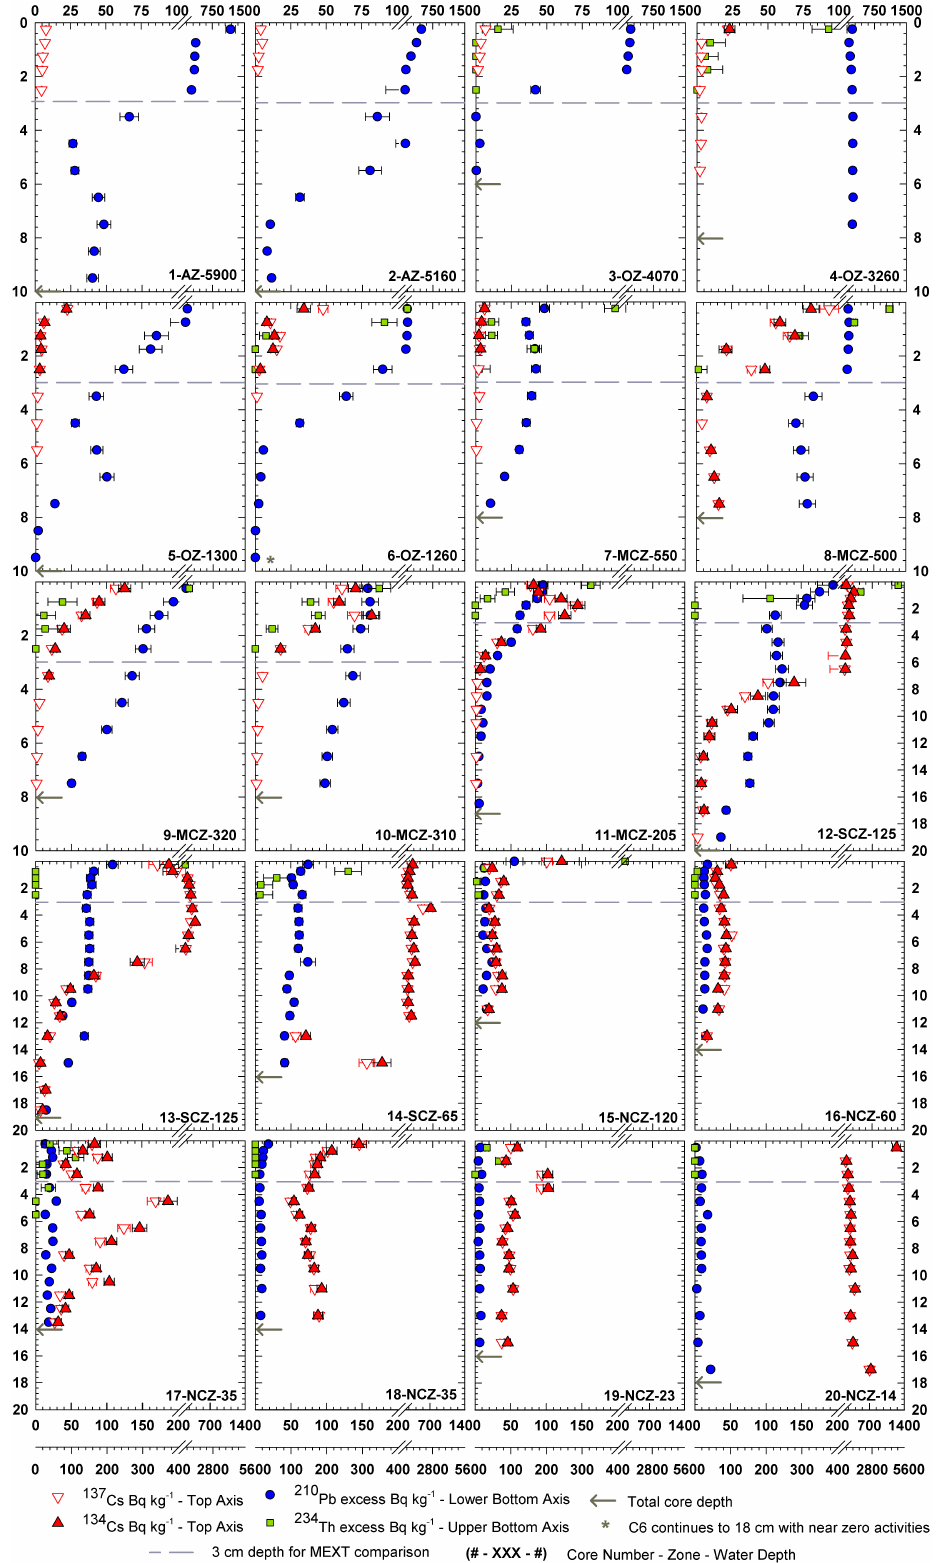
Figure 2. Sediment activity profiles in Bqkg − 1 for 134 Cs, 137 Cs, 210 Pb ex , and 234 Th ex